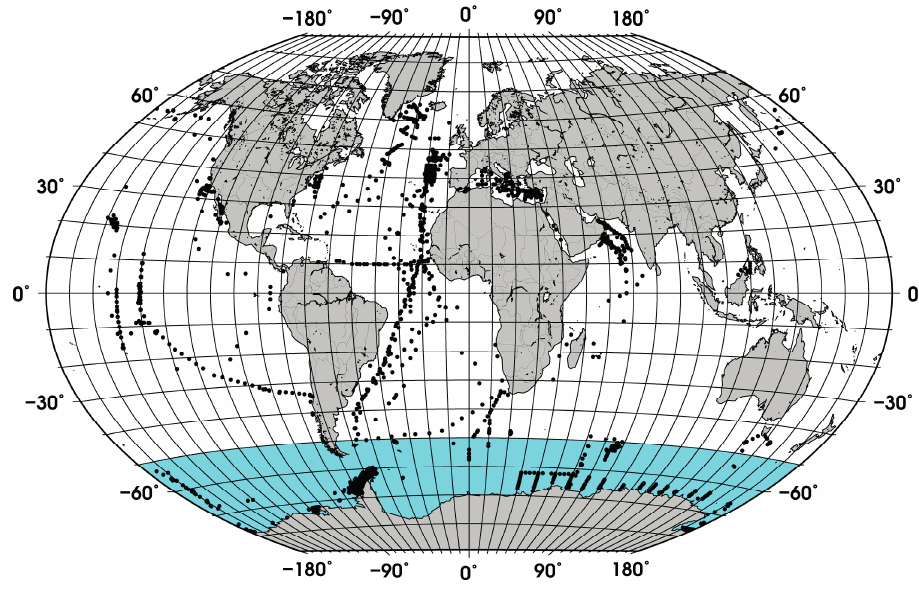
Figure 1. Distribution of the quality controlled in situ measurements. The SO, region south of 50°S, is the portion of the global ocean presented in